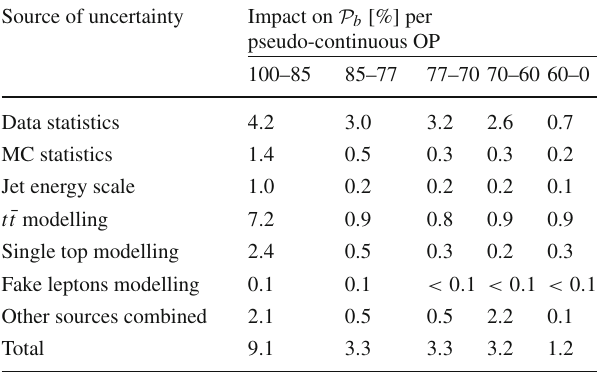
Table 6 Breakdown of the systematic uncertainties in the b -jet tag- ging probability measurement of the MV2 tagger as a function of the ‘pseudo-continuous’ bins for jets satisfying 110 ≤ p T < 140 GeV. The ‘ t ¯ t modelling’ and the ‘Single top modelling’ uncertainties correspond to the sum in quadrature of the uncertainty in the parton shower, hadro- nisation model, initial-state and final-state radiation and PDF for t ¯ t and single-top-quark production, respectively. The ‘Single top modelling’ uncertainties include an additional source originating from the interfer- ence between single top and t ¯ t production. ‘Other sources’ corresponds to the sum in quadrature of the uncertainties related to jet energy res- olution, electron and muon performance, b -tagging performance for light-flavour jets and c -jets, JVT performance, diboson and Z +jet mod- elling (including normalisation and shape uncertainties) and pile-up modelling. All systematic uncertainties are fully correlated bin-by-bin whereas the statistical uncertainty correlations are evaluated following the procedures described in Sect. 8. In the case of correlated systematic uncertainties, the relative sign of the uncertainty in each bin is taken into account, even if not shown